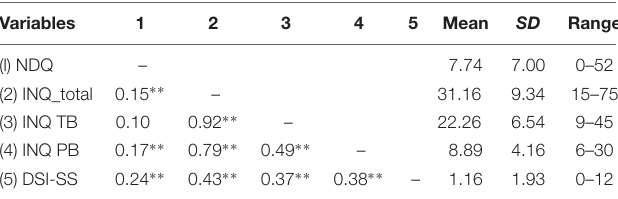
TABLE 1 | Means, standard deviations, and correlations between study